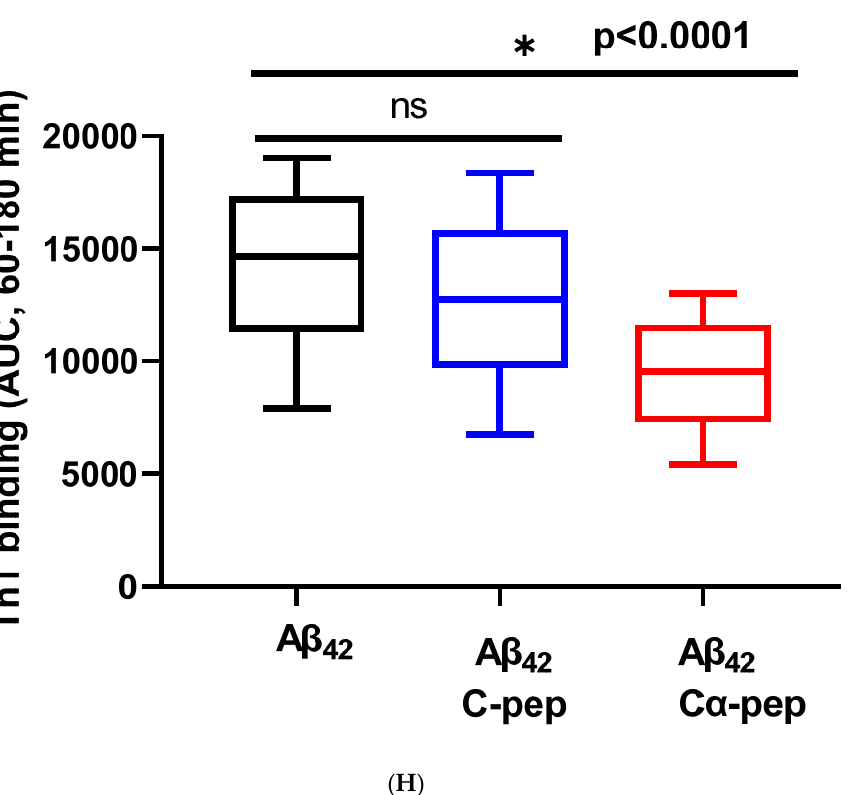
Figure 5. Inhibition of IAPP 37 and A β 42 fibrillation by IAPP 25 , DNSP 11 , and C α -peptide. Y-axis rep- resents the fluorescence intensity (F.I) of ThT binding and X-axis minutes. Representative fibrillation dynamics and inhibition curves in three replicates for ( A ) IAPP 37 with equal molar concentration of IAPP 25 and DNSP 11 ; ( B ) A β 42 with equal molar concentration of IAPP 25 and DNSP 11 ; ( C ) with equal molar concentration of of C- and C α -peptides; ( D ) thioflavin T (ThT) amyloid reporter assay of IAPP 25 and DNSP 11 ; IAPP 25 or DNSP 11 alone did not bind to the ThT amyloid reporter. ( E ) No inhibition of IAPP 37 fibrillation by insulin upstream open reading frame peptide occurs (INSU). Box-whisker plot of the inhibition. Y-axis is the area under the curve (AUC) of ThT fluorescence intensity. ( F ) Inhibition of IAPP 37 fibrillation by IAPP 25 and DNSP 11 in the range of 90–160 min. ( G ) Inhibition of A β 42 fibrillation by IAPP 25 and by DNSP 11 in the range of 30–120 min and ( H ) by C- and C α -peptide in the range of 60–180 min. ns: not